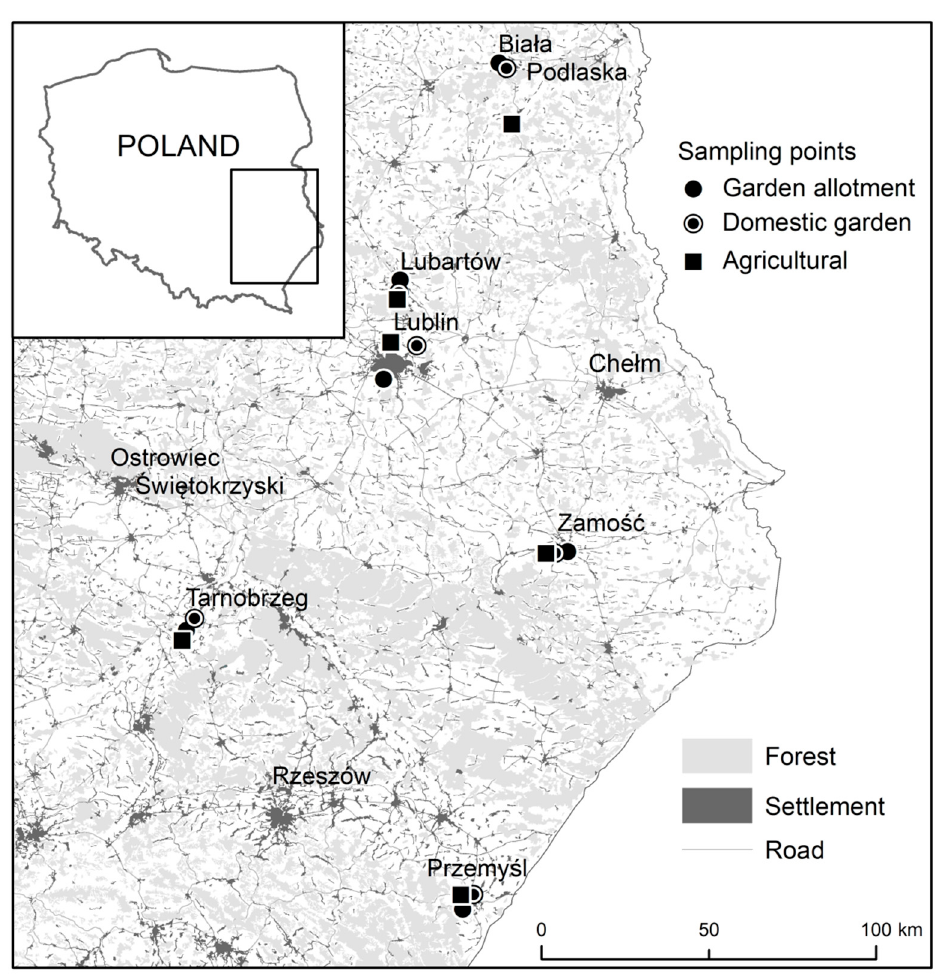
Figure 1. Map of sampling in the study area.